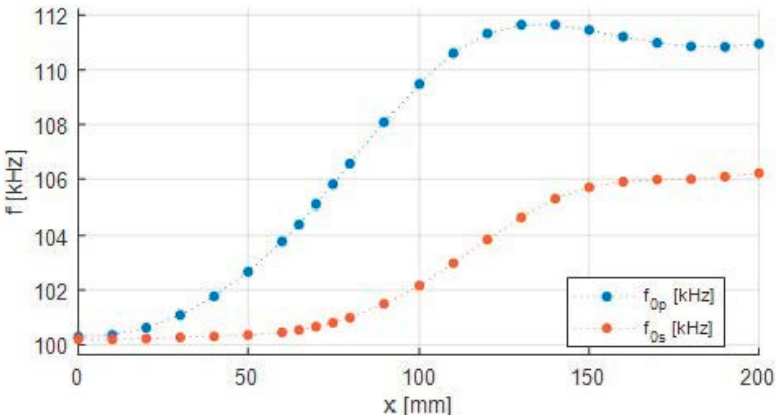
Figure 9. Detuning of the primary and secondary side.